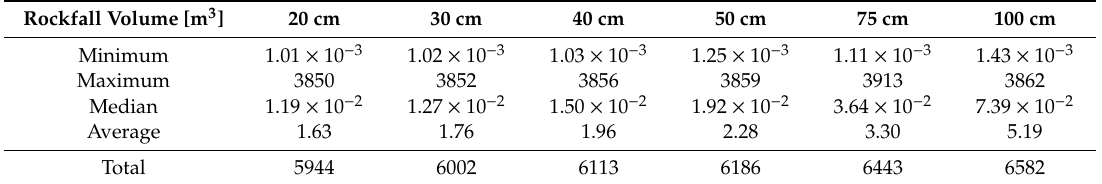
Table 2. Rockfall volume properties of each inventory with di ff ering M3C2 projection